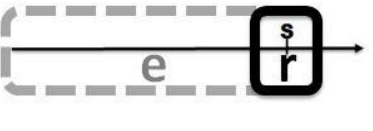
Figure 1. Resultative Anteriors, by contrast, refer to past events which extend to a present situation or that are relevant for it. Anteriors at stage 2 denote single past events e which extend to the moment of speech s ( persistence , Fig. 2a) or events which are iterated towards s and beyond ( iteration , Fig.